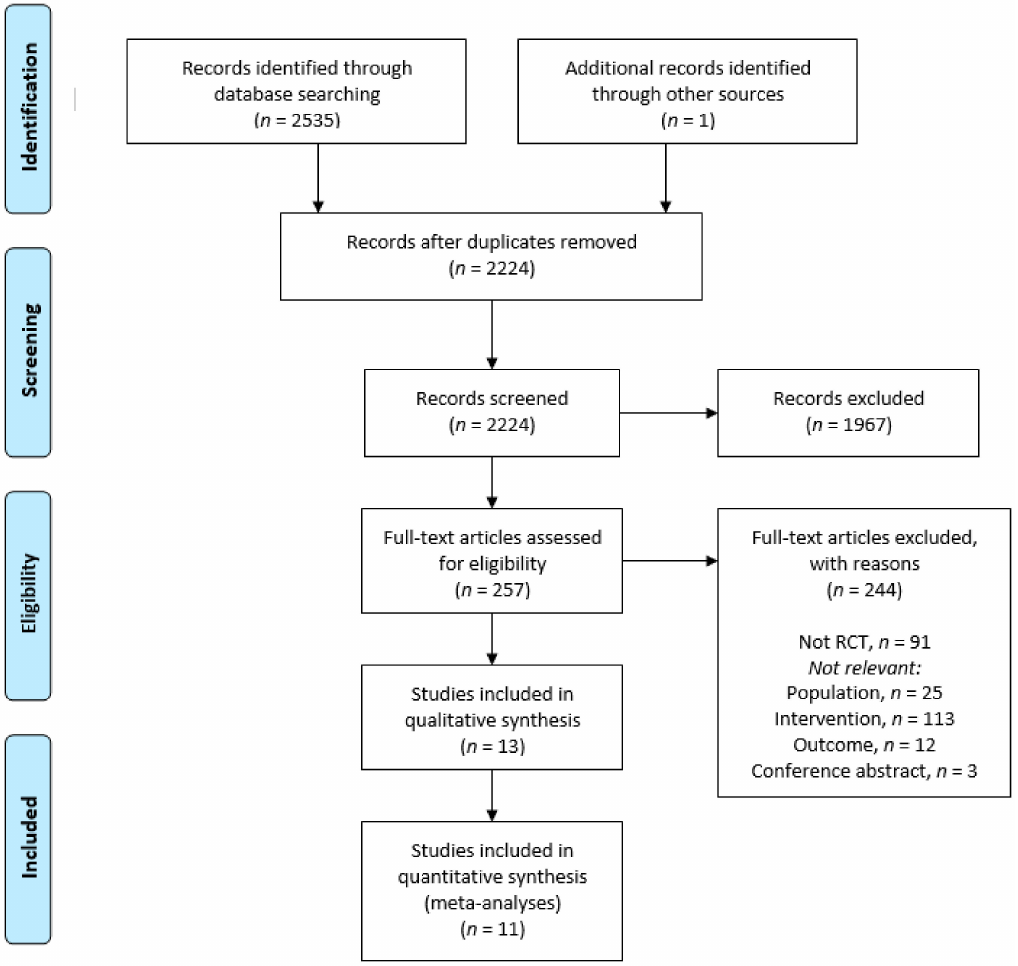
Figure 1. Preferred reporting items for systematic reviews and meta-analyses (PRISMA) flow diagram of reviewed and included